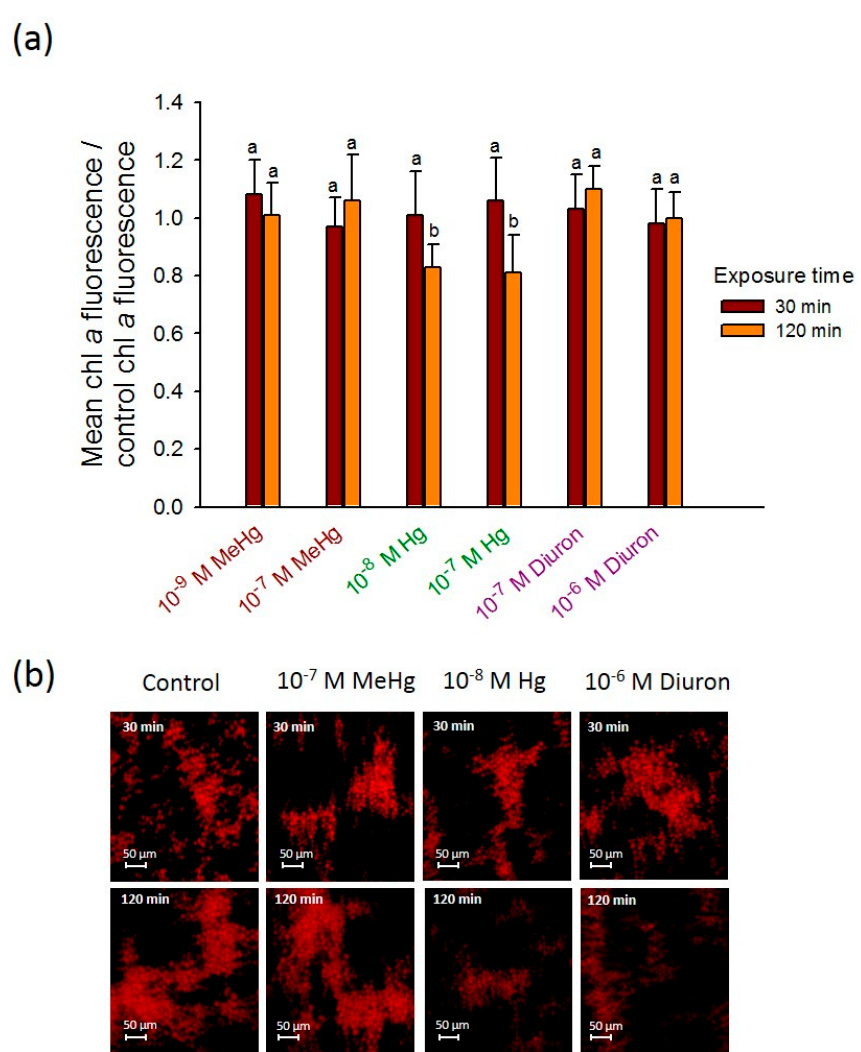
Figure 5. 2D-array sensing of chlorophyll fluorescence during short-term exposure. ( a ) Fluorescence intensity for different chemicals; The different letters indicate the presence or absence of statistically significant differences ( p < 0.05); ( b ) Example of fluorescence microscopy images of the chlorophyll of 2D-array by DEP. The cells in the formed non-uniform 2D-algal assembly of trapped cells after 30 or 120 min of exposure to contaminants.